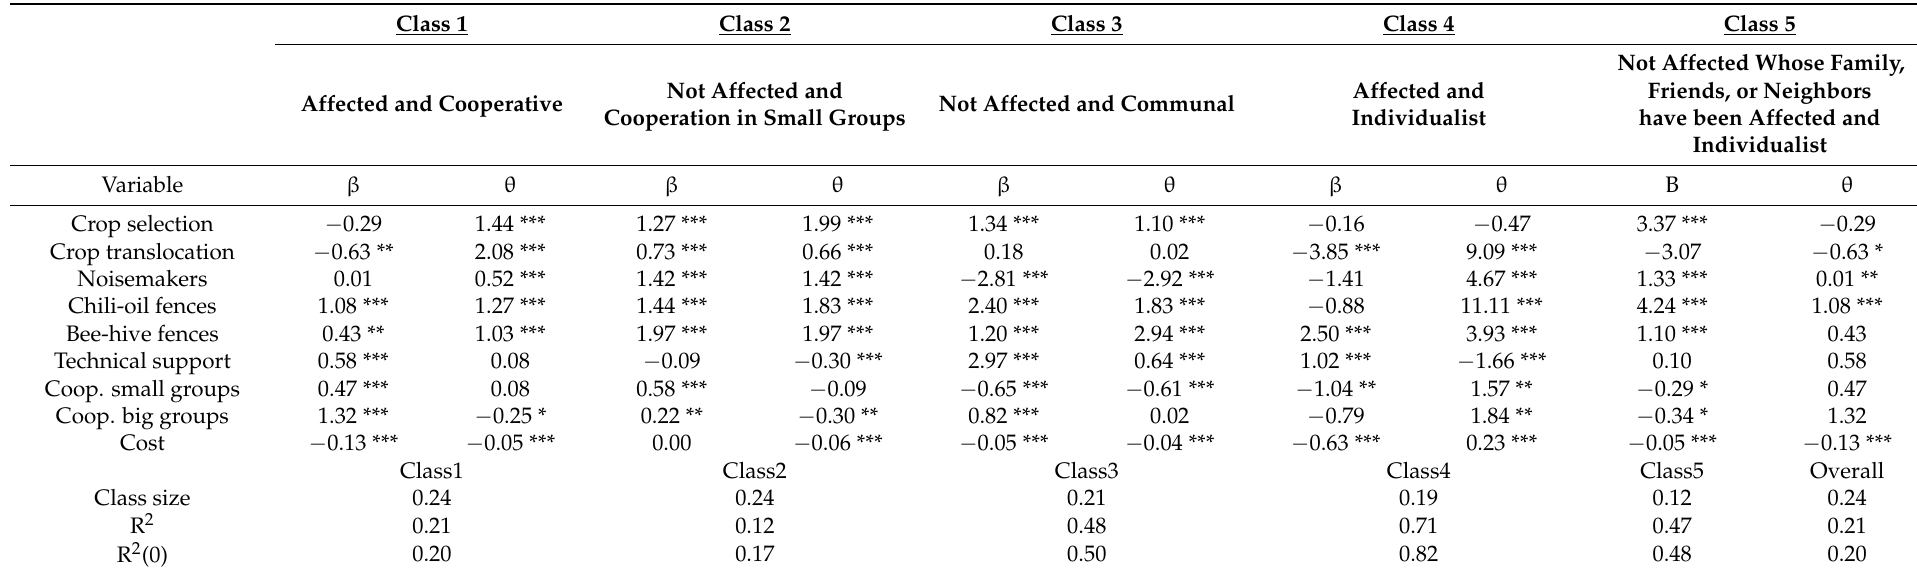
Table 2. Results of the latent class model of respondents’ preferences for management tools.